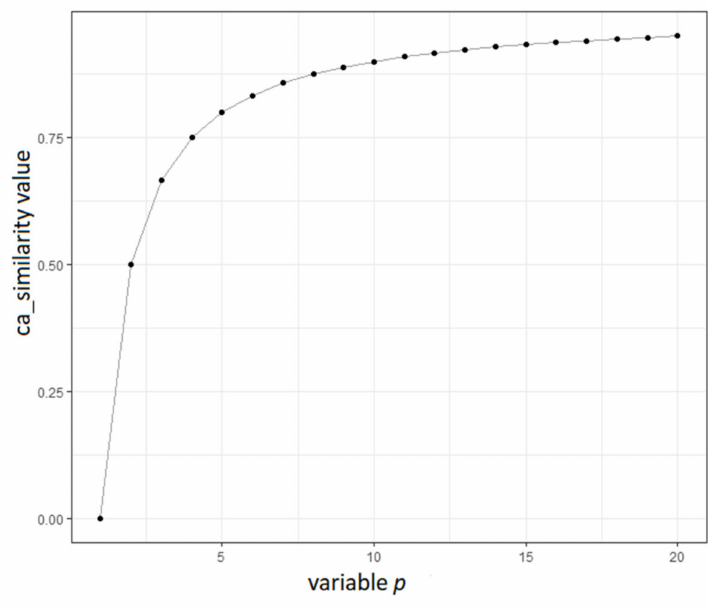
Figure 8. Plot of the ca _ similarity value against the variable p